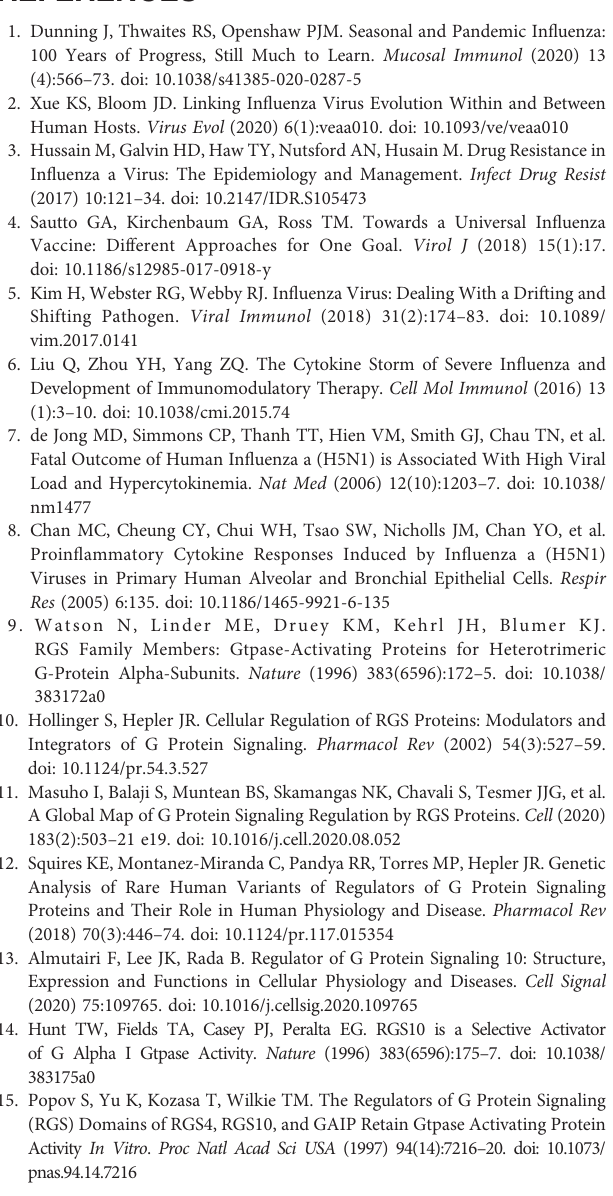
CD8 + , CD4 - ), CD4 T cells (CD45 + , CD3 + , CD4 + , CD8 - ), B cells (CD45 + , CD3 − , B220 + ), and natural killer cells (CD45 + , CD3 − , NK 1.1 + ). Supplementary Figure S5 | Characterization of leukocytes in uninfected airways of WT and Rgs10-/- mice. Indicated myeloid (A) and lymphoid (B) leukocyte subsets weremeasuredby fl owcytometry inBALFsofuninfectedWTand Rgs10-/- mice (n = 10). Data were analyzed for statistical differences using unpaired t-test between groups. Data are presented as mean ± SEM. Supplementary Figure S6 | No difference in the cellular pro fi ling between infected WT and Rgs10-/- at 3 dpi. Phenotypic analysis of myeloid and lymphoid leukocyte subsets was measured by fl ow cytometry in PR8-infected lung BALF of WT and Rgs10-/- mice (n = 9) at 3 dpi. Data were analyzed for statistical differences using unpaired t-test between groups. Data are presented as mean ±